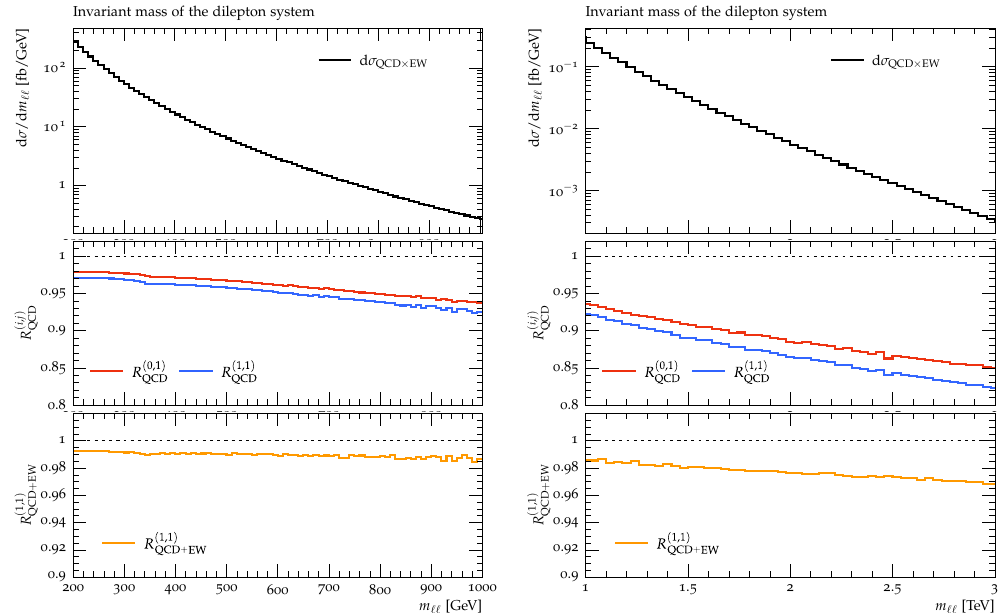
Figure 2 . Dilepton invariant mass distribution for the Drell-Yan process pp → ‘ − ‘ + at the 13.6 TeV LHC. The upper pane shows our best prediction for dσ which included NLO QCD, NNLO QCD, NLO EW, and mixed QCDxEW corrections. The middle pane shows the ratio of the NLO EW and mixed QCDxEW corrections to the full NLO QCD result. The lower pane shows the ratio of mixed QCDxEW corrections to a result which includes both QCD and EW NLO corrections. The left plot shows results in the range 200 GeV < m ‘‘ < 1 TeV , the right plot shows the range 1 TeV < m ‘‘ < 3 TeV . See text for